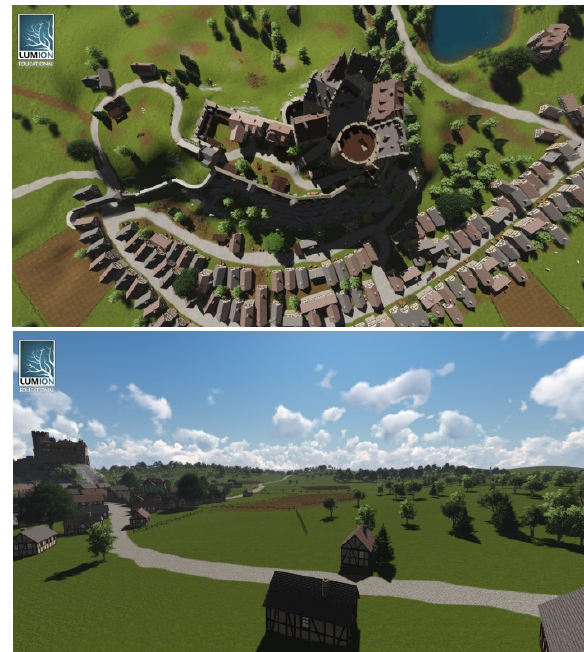
Figure 8. Top view (top) and side view (bottom) of the scene Urban area : The village of Segeberg (the "Bad" (bath)